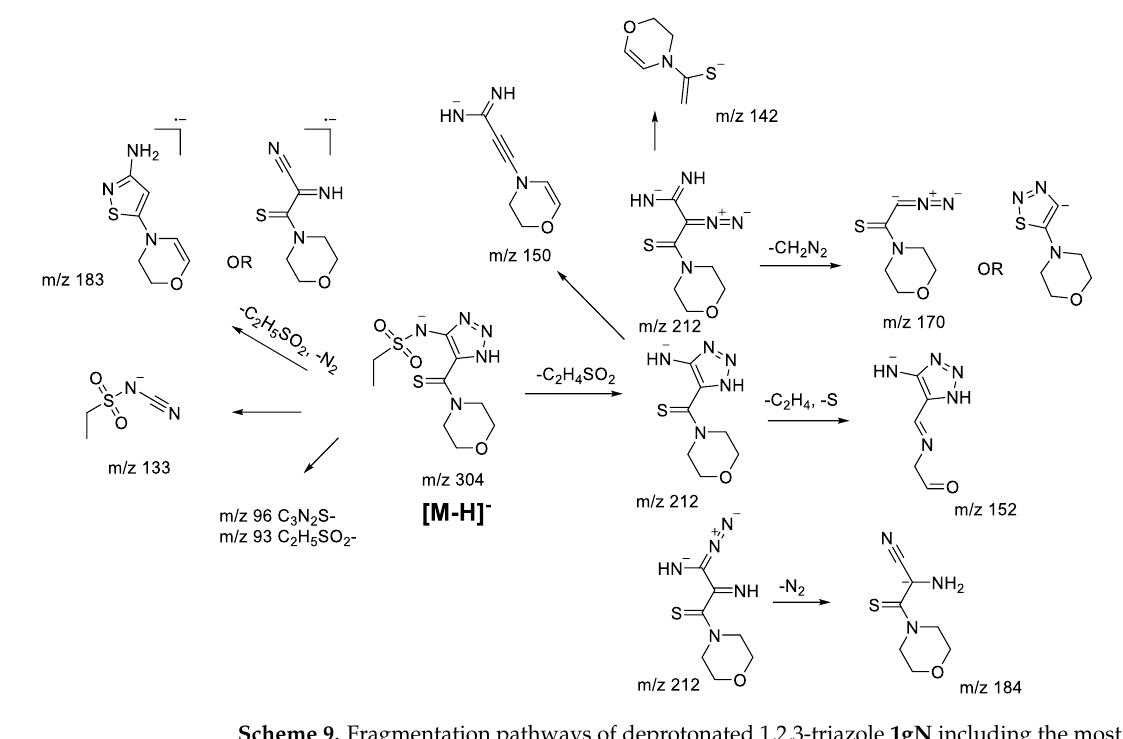
Scheme 9. Fragmentation pathways of deprotonated 1,2,3-triazole 1gN including the most charac- teristic ions formed under (−)ESI -MS/MS